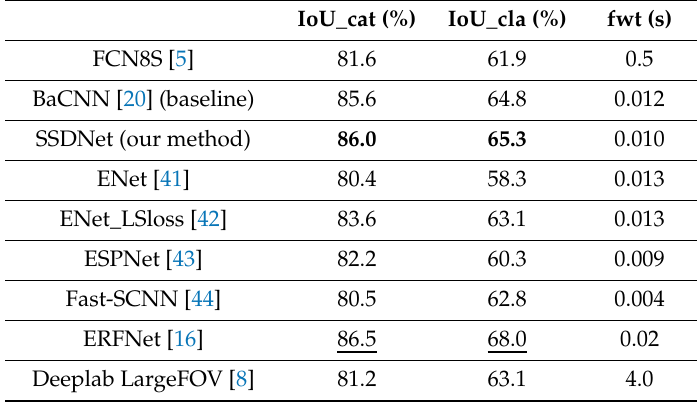
Table 4. Semantic segmentation results on CityScapes dataset with a resolution of 512 × 1024 px. IoU_cat